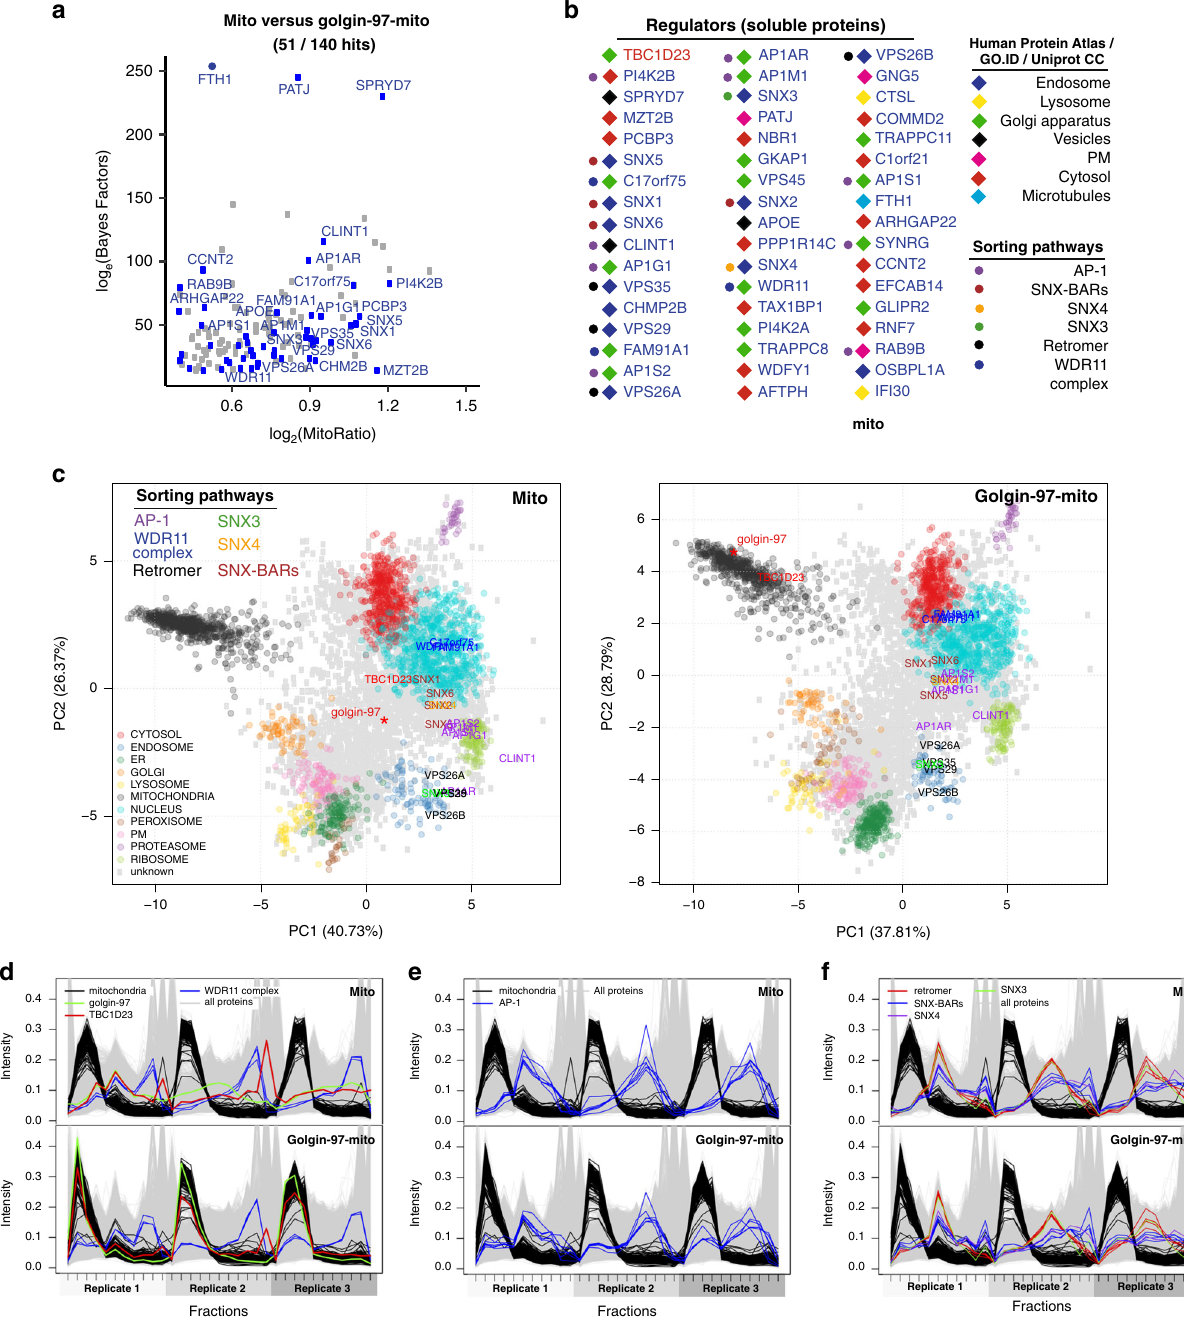
Fig. 3 Adaptor proteins and accessory factors of vesicles speci fi c to golgin-97. a MitoRatio versus Bayes Factor analysis of mito versus golgin-97-mito showing all hits (blue) that are both localised to the endosomal network and are also soluble proteins (axes truncated as in Fig. 2a). b All hits shown in a ordered from left column to right column based on descending MitoRatio scores. Classi fi cation of their localisation and sorting pathway is based on multiple localisation databases and literature. c PCA projections for the LOPIT-DC of mito versus golgin-97-mito showing SVM classi fi cations and the indicated proteins coloured based on the sorting pathway they have been proposed to belong to a , b . d – f . TMT reporter ion distributions of proteins across fractions for each replicate for mito versus golgin-97-mito showing the pro fi les of known mitochondrial markers (mitochondria) and all hits from a , b that have been reported belong to the indicated sorting